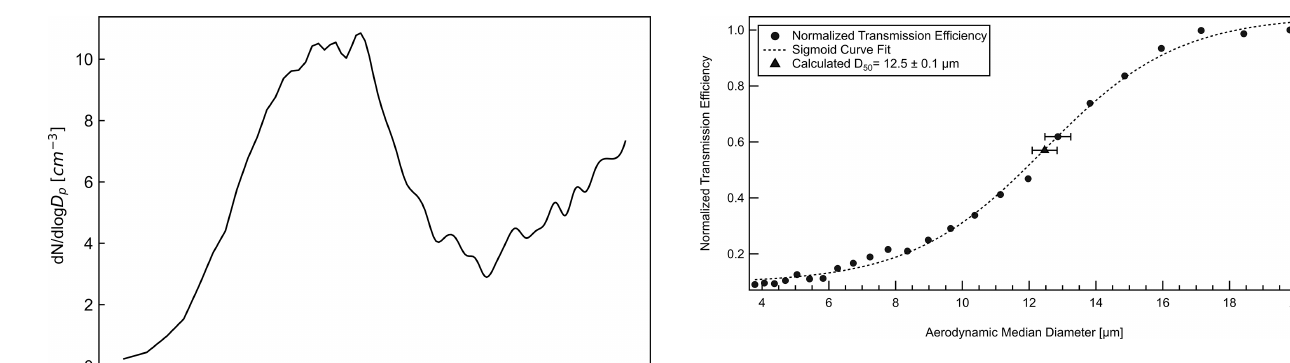
Figure 4. Transmission efficiency from the L-PCVI as a function of particle aerodynamic diameter (solid circles) fit with a sigmoid (solid line). The triangle represents the size at which 50% of parti- cles are transmitted (the experimental D50). The representative er- ror, ± 3%, due to instrument uncertainty, is shown on a point close to the D50 and on the